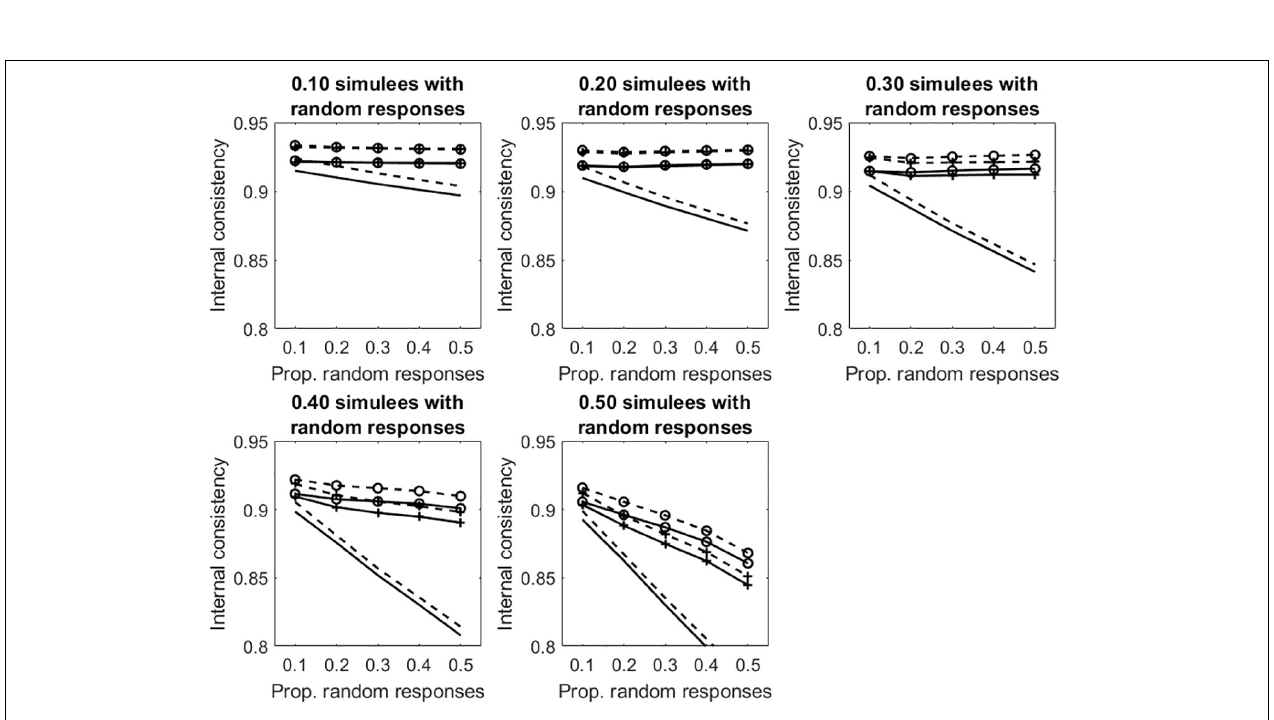
FIGURE 7 | Average internal consistency for the different proportions of simulees with random responses and the different proportions of polytomous items with random responses. The solid lines represent α , the dashed lines represent R. The unmarked lines represented the full, uncleaned data sets. The +-marked lines represent infit-cleaned data sets. The o-marked lines represent the outfit-cleaned data